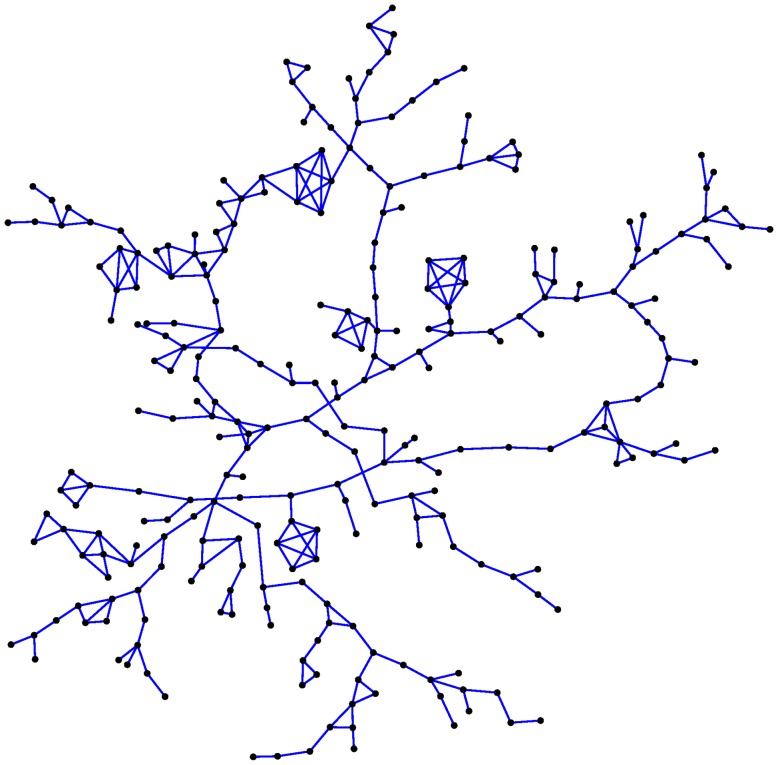
Typical simulated PWID network with 274 nodes.